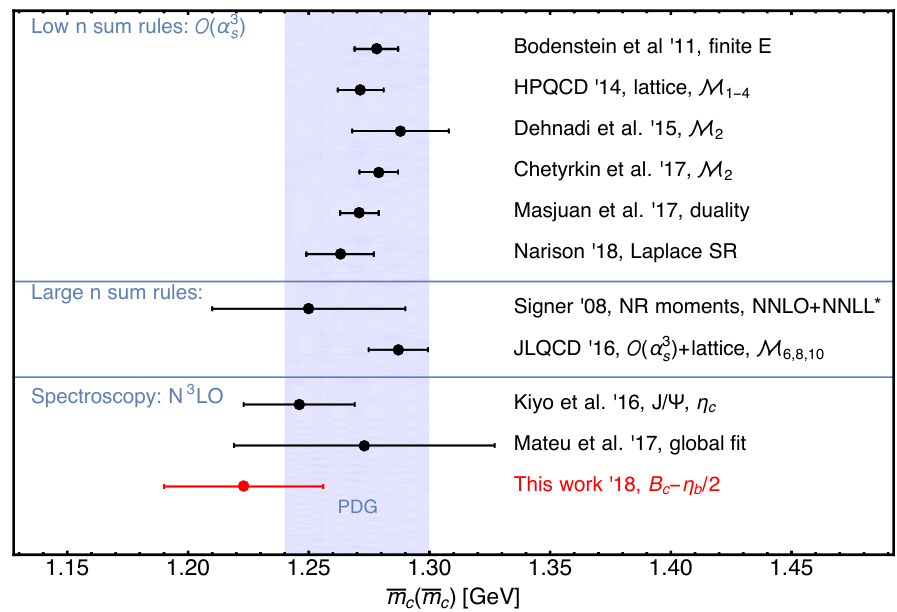
Figure 4 . m c ( m c ) determined from spectroscopy or from sum rules in the strict weak-coupling ap- proximation. Chetyrkin et al. [52], HPQCD14 [38], and Dehnadi et al. [39] use N 3 LO low n moments equated to the corresponding experimental moments evaluated using the available experimental in- formation (masses and decays) supplemented with lattice information and/or assuming